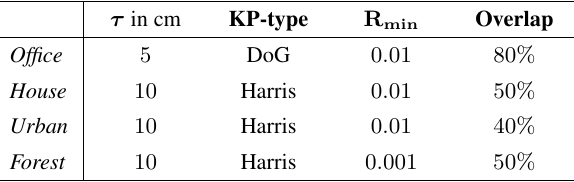
Table 1: Fixed K-4PCS parameters for the different test data sets.